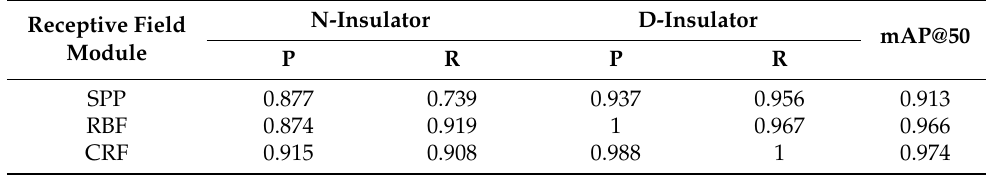
Table 1. Comparison of different receptive field